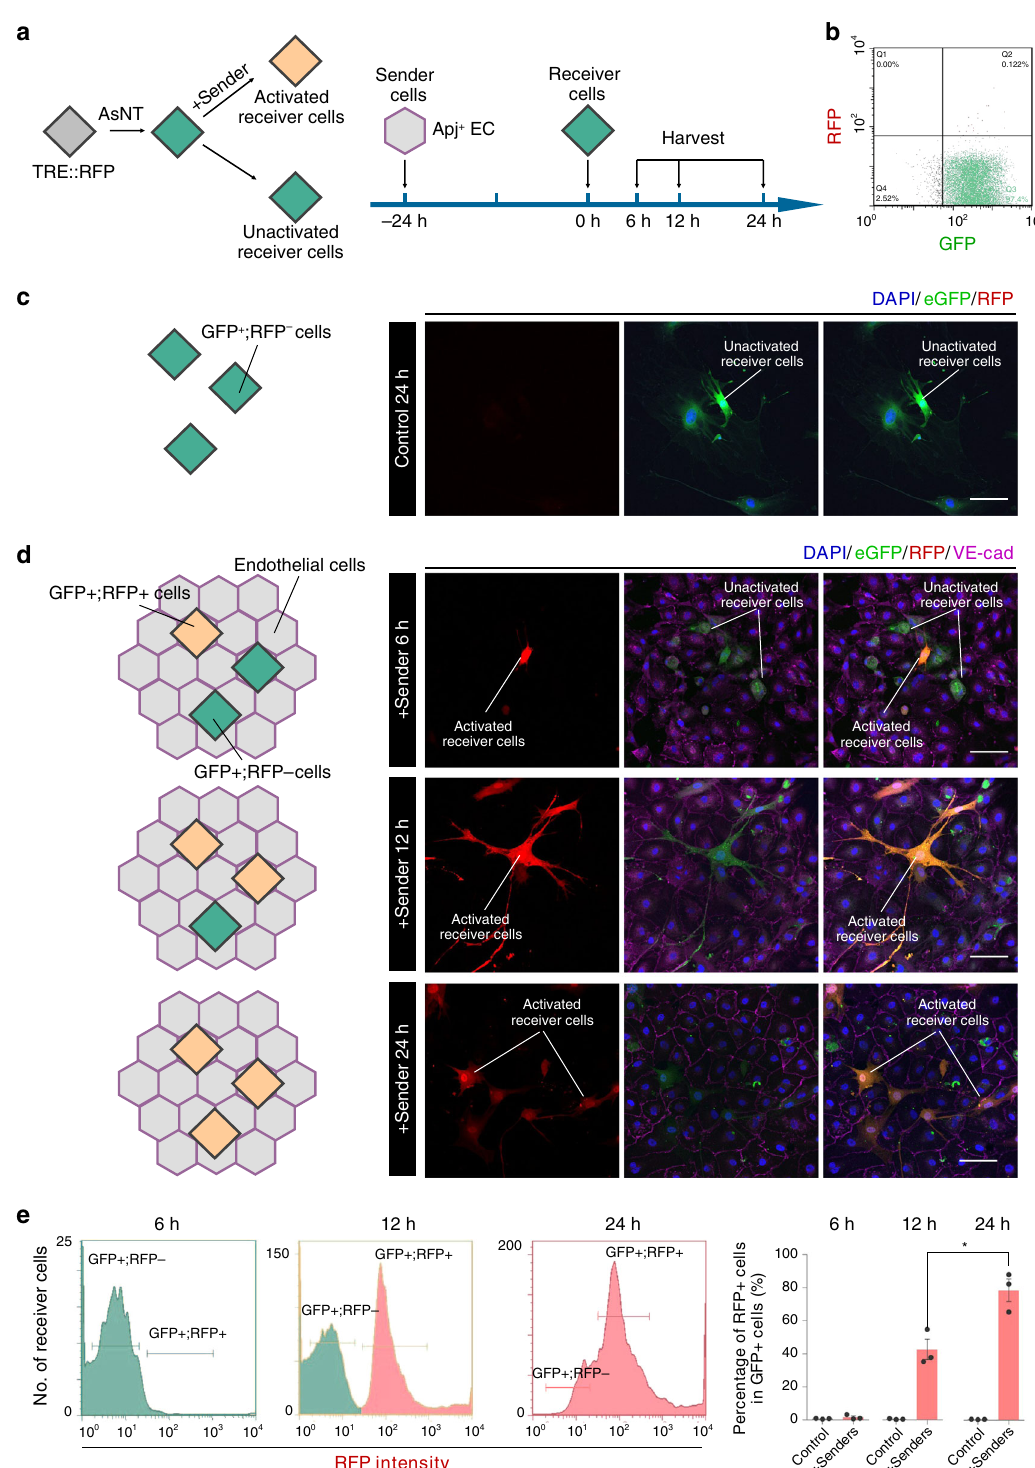
Fig. 3 AsNRs can drive customized programs after being activated. a Experimental strategy to test the effectiveness of customized program activation. The RFP reporter gene is promoted by TRE and the reporter is activated after tTA is released from the membrane. Colored diamonds represent receiver cells in different states: green, RFP reporter that is not activated; orange, RFP reporter that is activated. b Analysis of receiver cells after sorting by fl ow cytometry showing that receiver cells did not activate the RFP reporter. c Image of fl uorescence showed that the RFP reporter in the receiver cells was not activated without contact with the sender cells. d After adding HUVECs (sender cells), the receiver cells turned red within 24 h after cell – cell contact. e Quanti fi cation of the receiver cells showed that the number of RFP + receiver cells gradually increased within 24 h. Scale bars = 50 μ m in c and d . Error bars: SEM. Signi fi cance: * p < 0.05 ( n = 3 samples per group in e